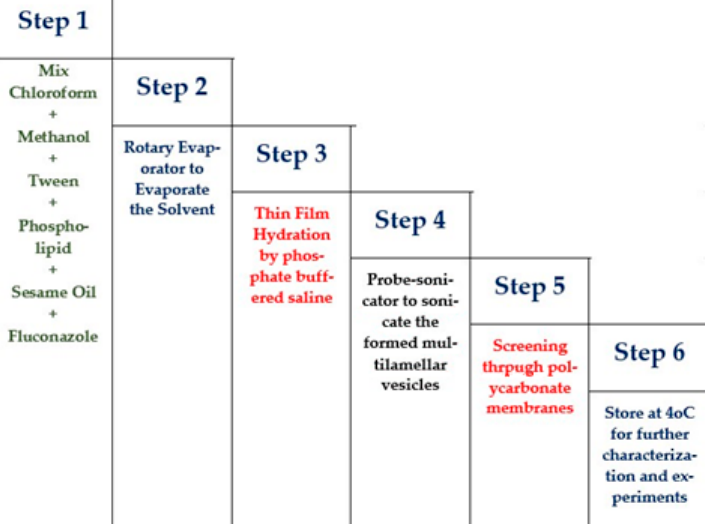
Figure 1. Schematic representation of steps of preparation of fluconazole-sesame oil nanotransfer- somes